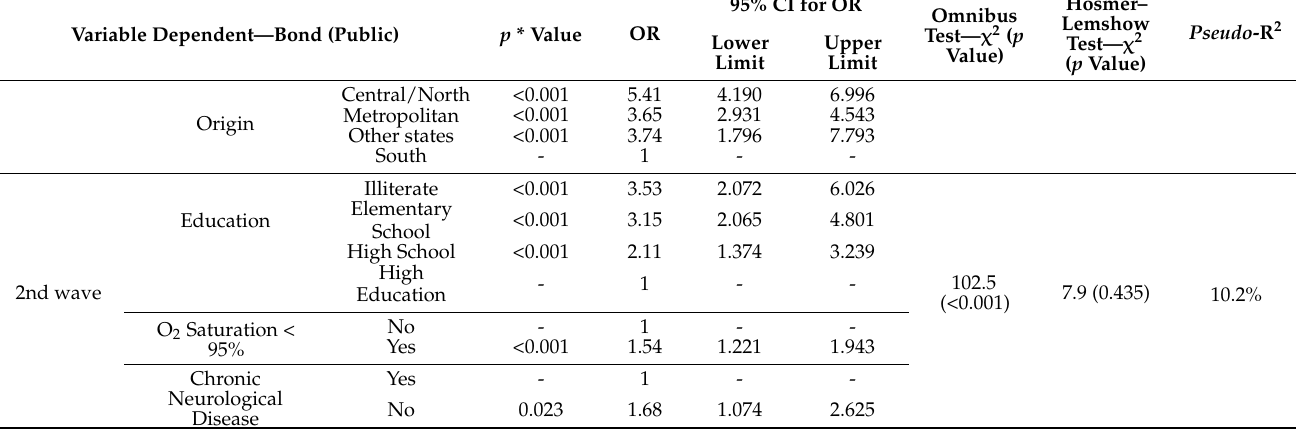
Table 3. Association of the public bond with the socio-clinical variables for the second wave of death incidence. From April 2020 to August 2021, Esp í rito Santo,